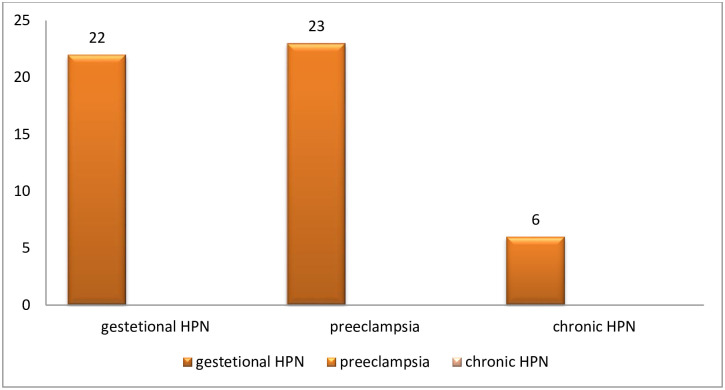
Types of hypertension.